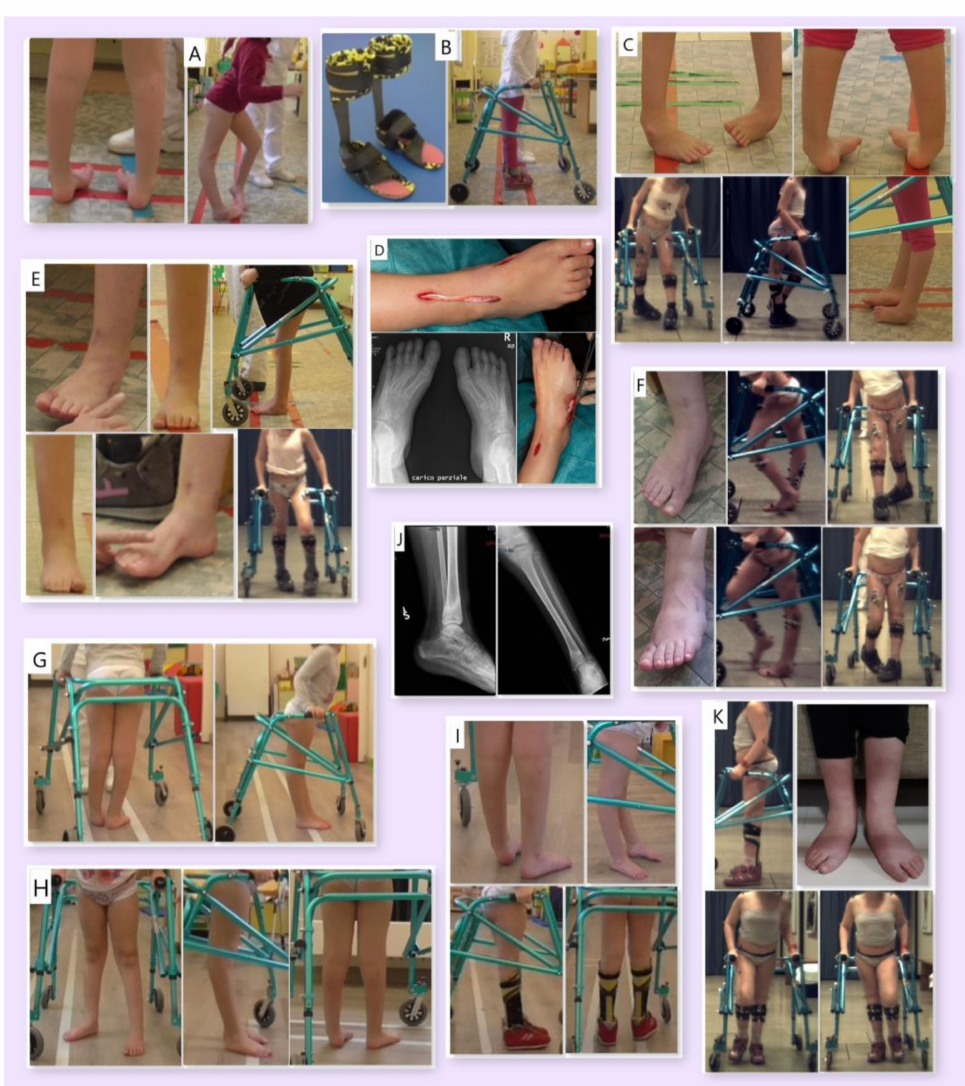
Figure 1. Images of the patient: at first access to the rehabilitation unit (( A ), age 75 months); AFOs and walker (( B ), age 76 months); pre-surgery (( C ), age 88 months); intraoperative (( D ), age 91 months); 4 and 9 months after surgery, respectively (( E ), age 96 months; ( F ), age 100 months); pre-botulinum toxin injection (( G ), age 104 months); 1 month after botulinum toxin injection (( H ), age 105 months); 4 months after botulinum toxin injection (( I ), age 109 months); left tibial fracture (( J ), age 111 months); last assessment (( K ), age 121